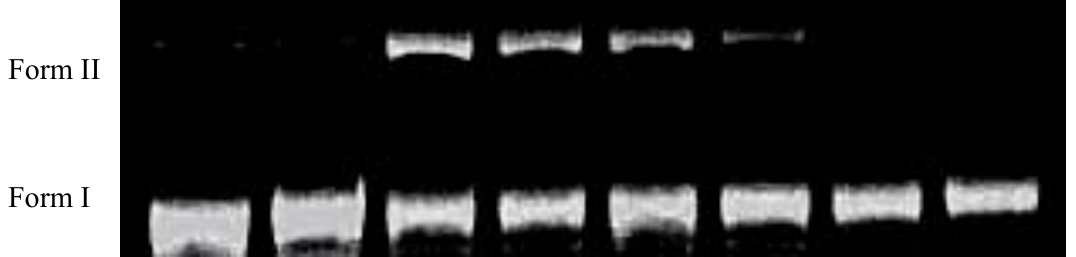
Figure 4. Dose measurement of compound 4c for DNA cleavage. Lane 1, DNA at 312 nm for 2 h; Lane 2, DNA and 4c (500 μ M) in the dark; Lanes 3–8, DNA and 500, 250, 100, 50, 25, 12.5 μ M of 4c , individually, at 312 nm for 2